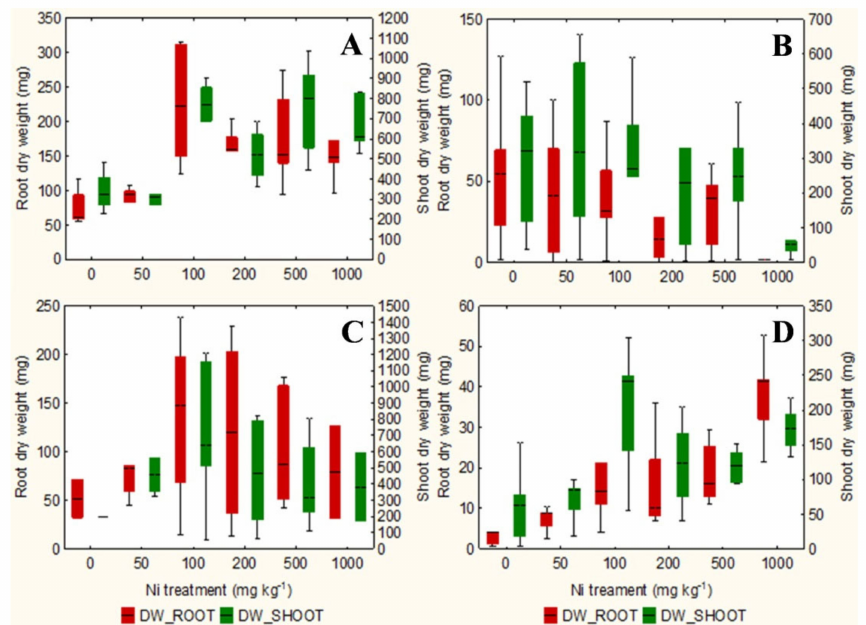
Figure 2. Box-and-whisker plots showing the root and shoot dry biomass (mg) of test hyperaccumu- lator species at increasing Ni concentrations (0–1000 mg kg − 1 ): ( A ) A. utriculata , ( B ) N. caerulescens and non-hyperaccumulator species ( C ) A. montanum, ( D ) T. arvense. In each box, the central line marks the median of the data; the box edges represent the first and third quartiles; whisker show non-outlier range. n = 20 each